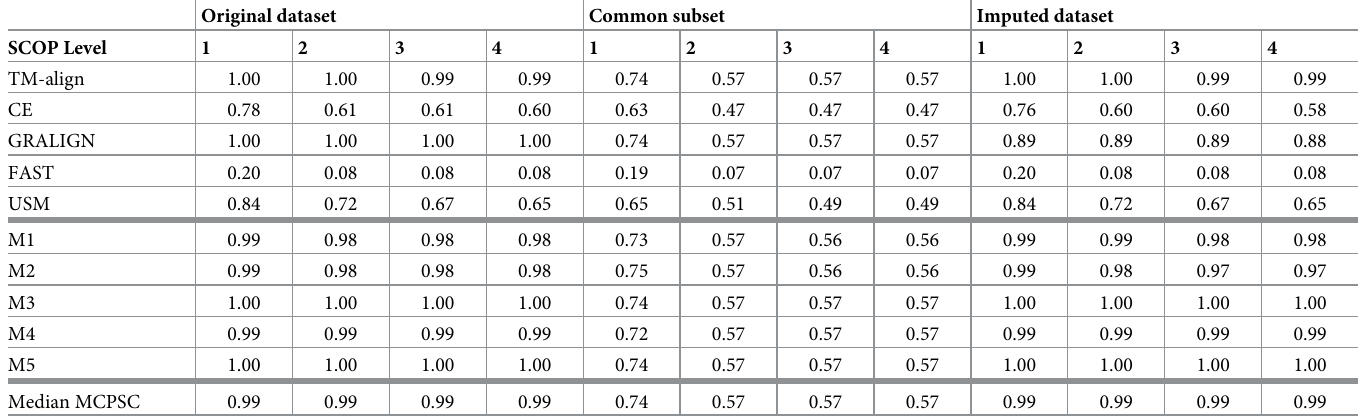
Table 3. Fraction of domains correctly classified at different SCOP hierarchy levels using a Nearest-Neighbor classifier built with similarity scores produced by dif- ferent PSC and MCPSC methods. In the SCOP hierarchy: Level 1 = Class, Level 2 = Fold, Level 3 = Superfamily and Level 4 = Family. Original